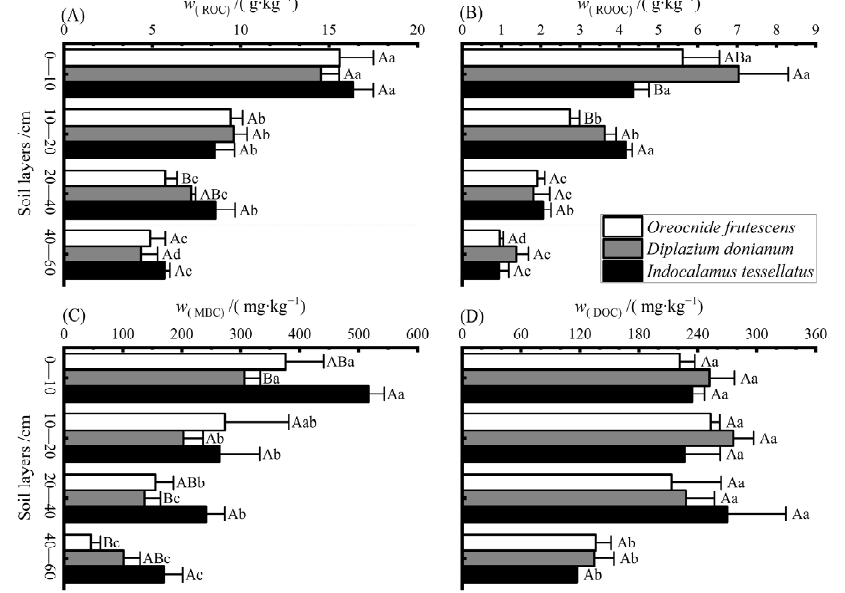
Figure 3. Mass fraction of each soil organic carbon component. ( A ): the mass fraction of ROC; ( B ): the mass fraction of ROOC; ( C ): the mass fraction of MBC; ( D ): the mass fraction of DOC. ROC (Recalcitrant organic carbon), ROOC (Readily oxidizable organic carbon), MBC (Microbial biomass carbon), DOC (Dissolved organic carbon). Different uppercase letters indicate significant differences between understory vegetation types, and different lowercase letters indicate significant differences between soil layers. ( p < 0.05).